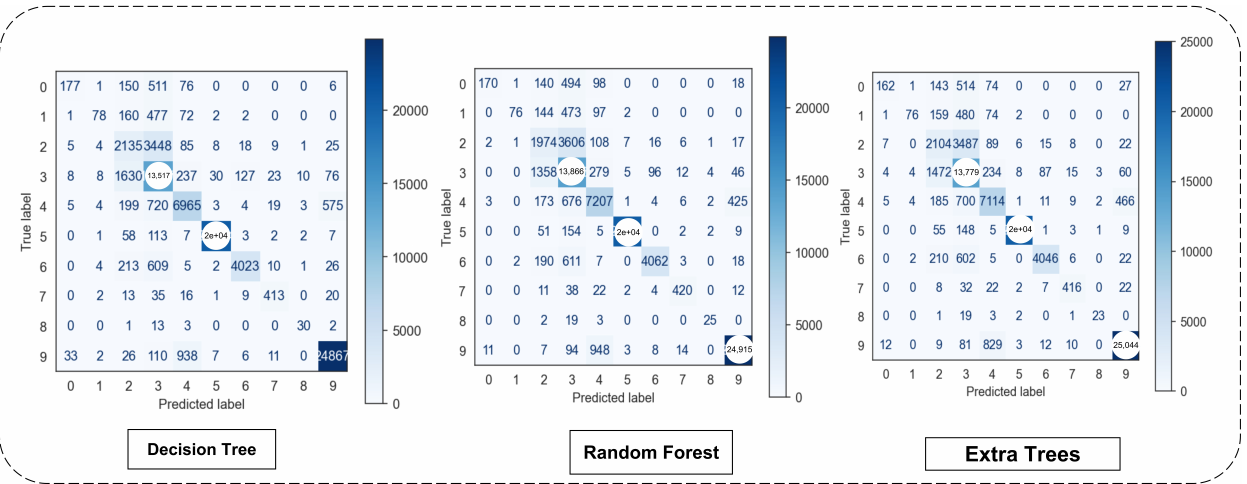
Figure 6. Confusion matrices of multi-class classification on original + GAN-based new dataset (second 3 classifiers).